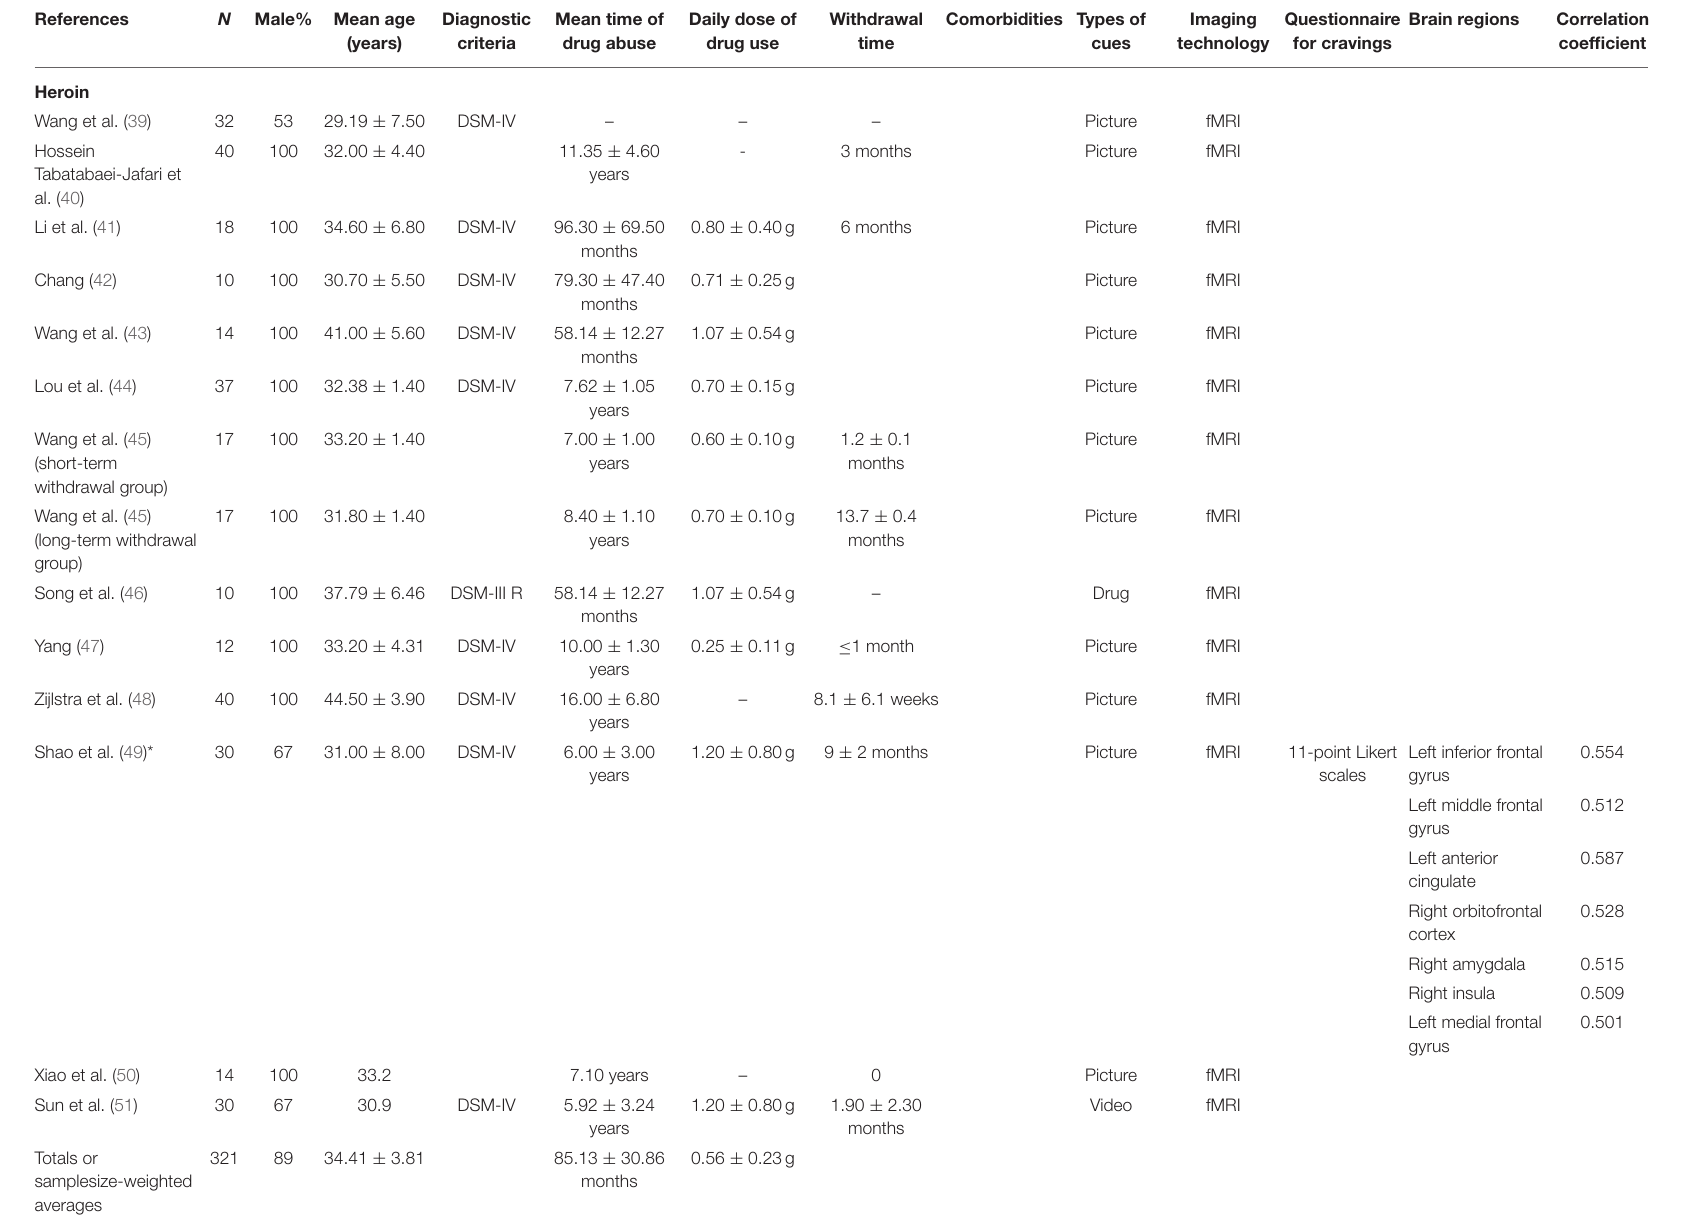
TABLE 1 | Characteristics of the